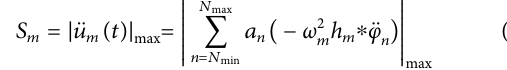
Frontiers in Earth Science |